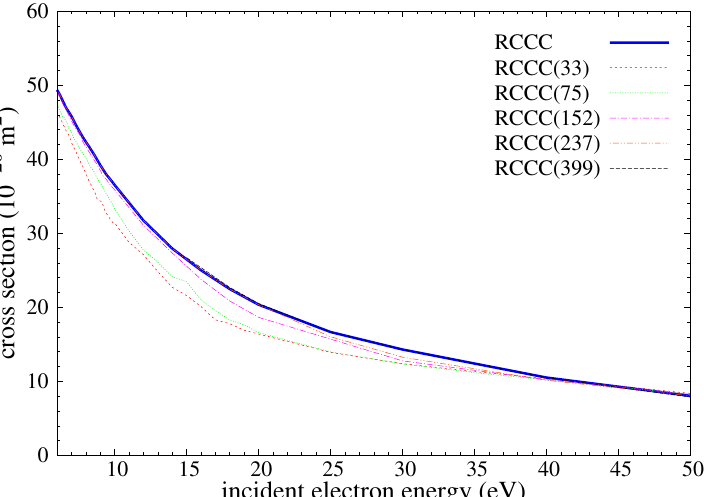
Figure 3. Convergence of the RCCC result for elastic scattering on the ground 3 P 0 state of tin with the number of states included in the close-coupling expansion. Presented for the intermediate-to- high-energy